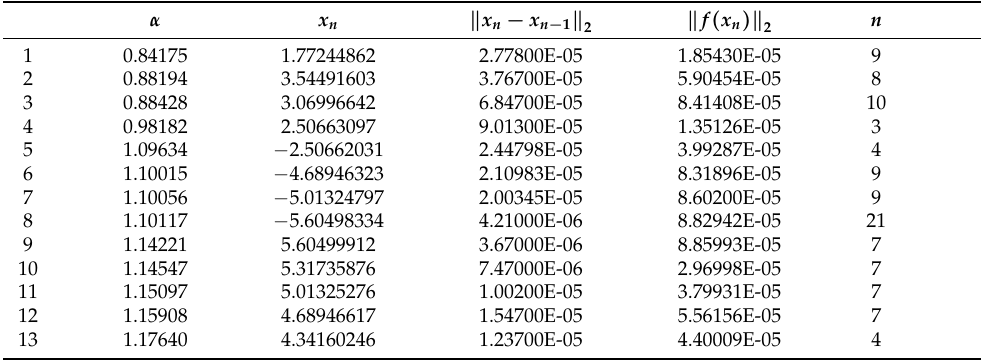
Table 7. Results obtained using the iterative method (50).